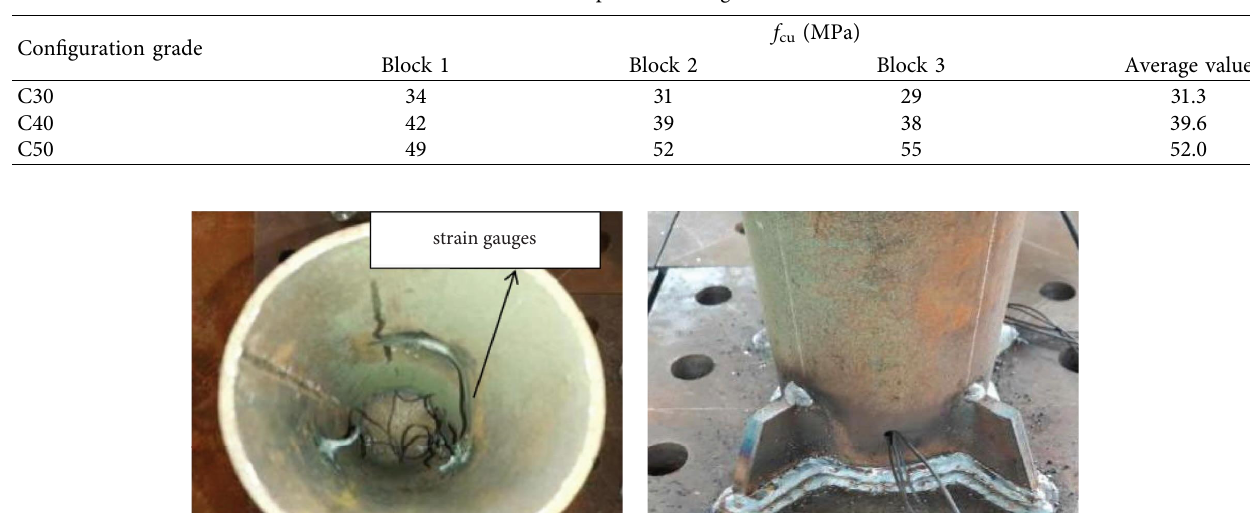
Figure 3: Concrete test block confguration diagram: (a) block confguration and (b) compression Table 5: Test block compressive strength measured table.